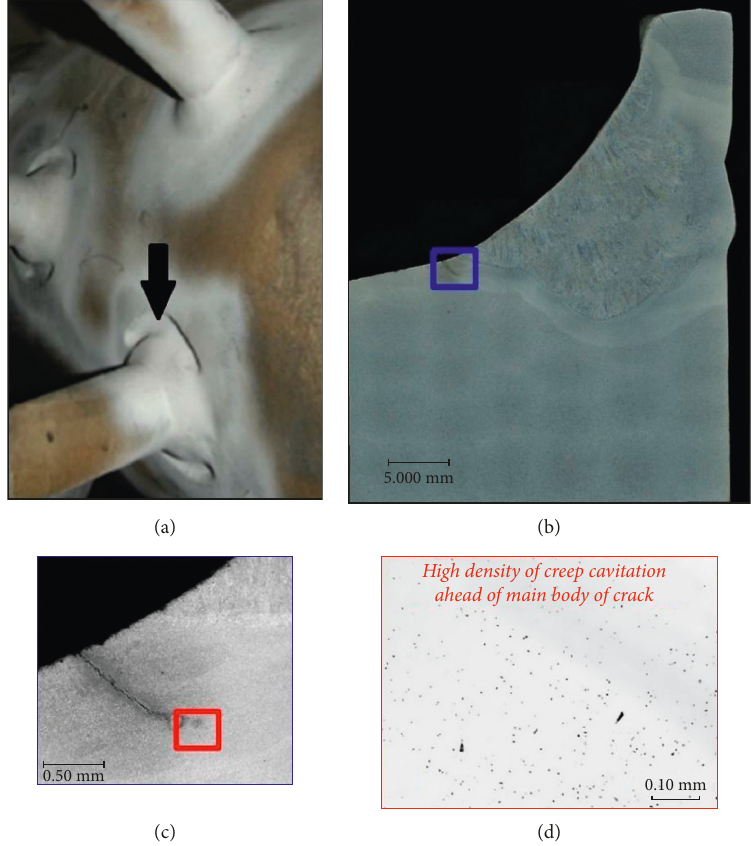
Figure 2: Example of in-service damage from Grade 91 heat “B2” [5]. The density of cavitation ahead of the crack varied from 700 to 1,000 voids/mm 2 and closely matches known maximum densities responsible for macrocracking in Grade 91 heat-affected zones ( ∼ 1,000 voids/mm 2